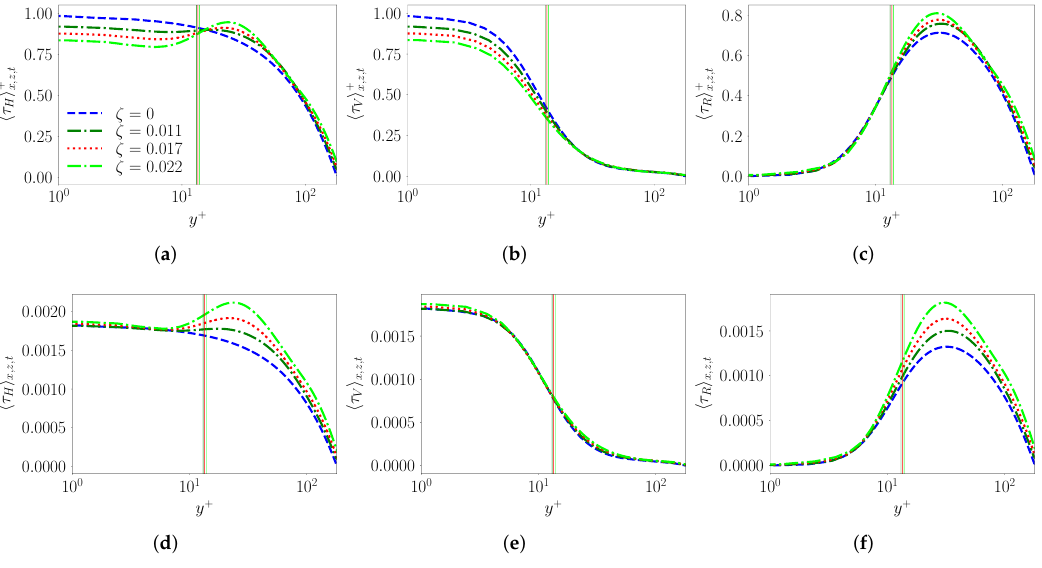
Figure 12. The schematic shows the inner scaled mean ( a ) horizontal stress, ( b ) viscous stress, and ( c ) Reynolds stress in the top row and the dimensional mean ( d ) horizontal stress, ( e ) viscous stress, and ( f ) Reynolds stress in the bottom row. The vertical lines correspond to the different a +